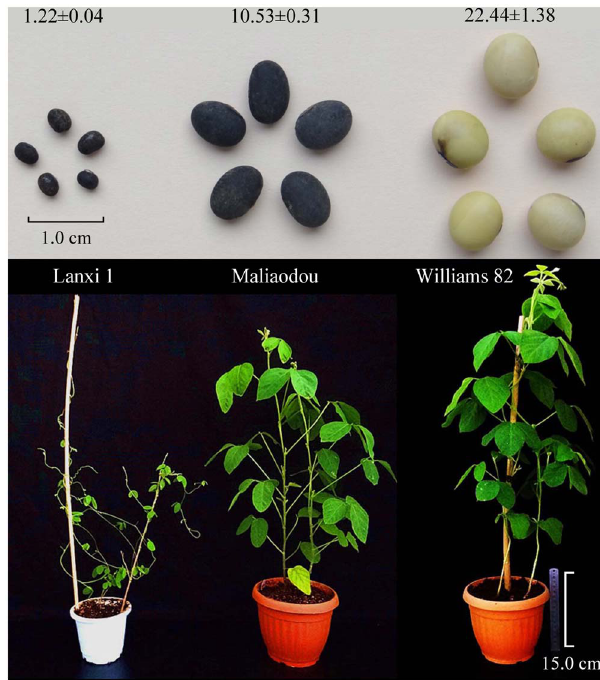
Figure 1. Phenotypes of cultivated, semi-wild and wild soybeans used in the present study. Seed weight (per 100 seeds) and plant architecture are shown.